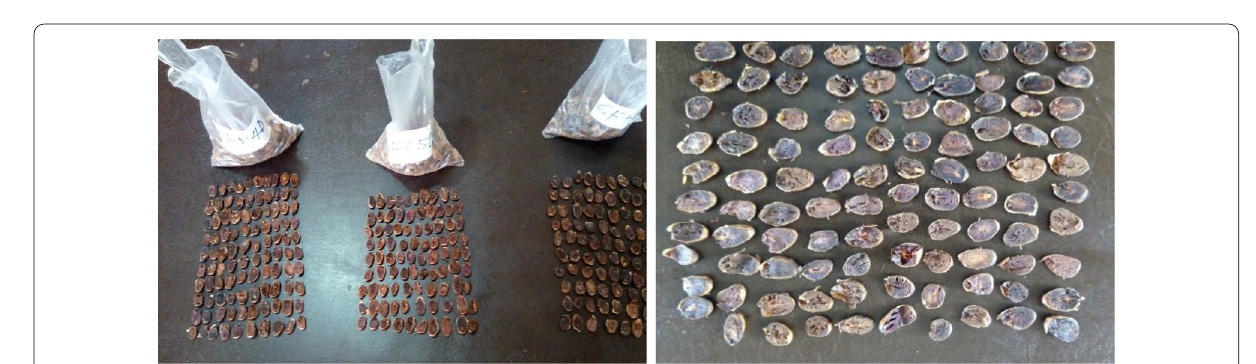
Fig. 3 Cross-longitudinal section of cut cocoa beans for identifying defective beans after